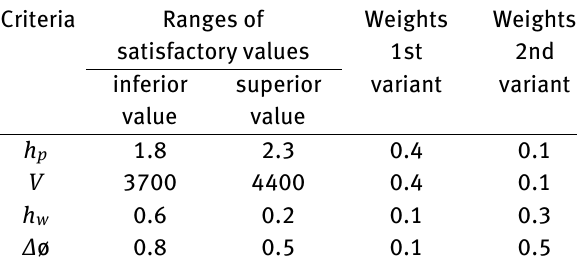
Table 3: Summary of ranges of satisfactory values and